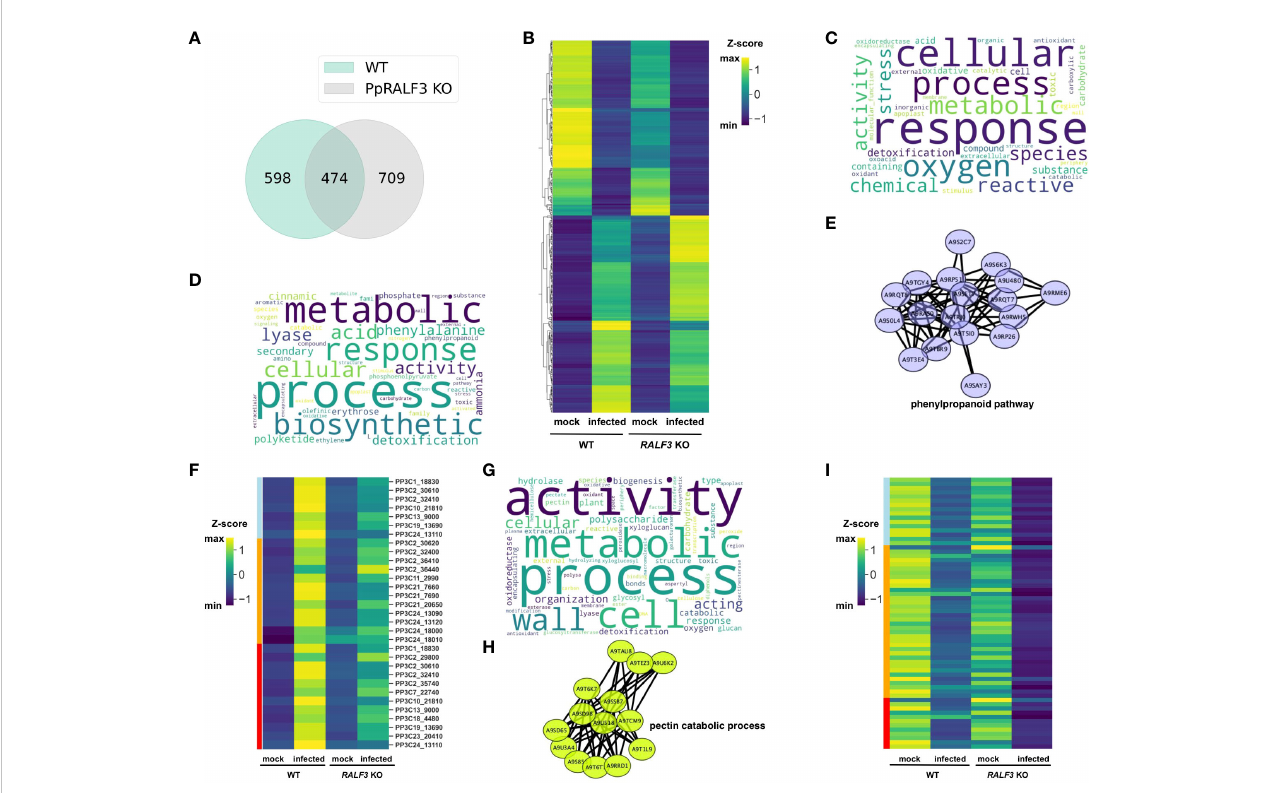
FIGURE 5 (A) Venn diagram depicting overlapping differentially regulated genes (DEGs) between wild-type and PpRALF3 KO lines; (B) A heat map depicting transcript levels of overlapping between wild-type and PpRALF3 KO differentially expressed genes. Normalized transcripts per million (TPM) values are shown; (C) Gene ontology (GO) terms bias word cloud. Word cloud of enriched GO terms for overlapped DEGs between wild-type and PpRALF3 KO lines is shown (false discovery rate (FDR) adjusted P -values ≤ 0.05); (D) GO terms bias word cloud. Word cloud of enriched GO terms in wild-type plants is shown (false discovery rate (FDR) adjusted P -values ≤ 0.05); (E) Protein – protein interaction networks of a group of upregulated differentially expressed genes in wild-type plants that belong to phenylpropanoid metabolic process. Genes are indicated with nodes, and interactions between proteins are represented by edges; (F) A heat map depicting transcript levels of DEGs that belong to “ phenylpropanoid biosynthetic process ” (lightblue), “ polyketide metabolic process ” (orange), “ aromatic amino acid family metabolic process ” (red). Normalized transcripts per million (TPM) values are shown; (G) GO terms bias word cloud. Word cloud of enriched GO terms in PpRALF3 KO plants is shown (false discovery rate (FDR) adjusted P -values ≤ 0.05); (H) Protein – protein interaction networks of a group of down regulated differentially expressed genes in PpRALF3 KO plants that belong to the pectin catabolic process. Genes are indicated with nodes, and interactions between proteins are represented by edges. (I) A heat map depicting transcript levels of DEGs that belong to “ pectin metabolic process ” (lightblue), “ cell wall organization or biogenesis ” (orange), “ xyloglucan:xyloglucosyl transferase activity ” (red). Normalized transcripts per million (TPM) values are